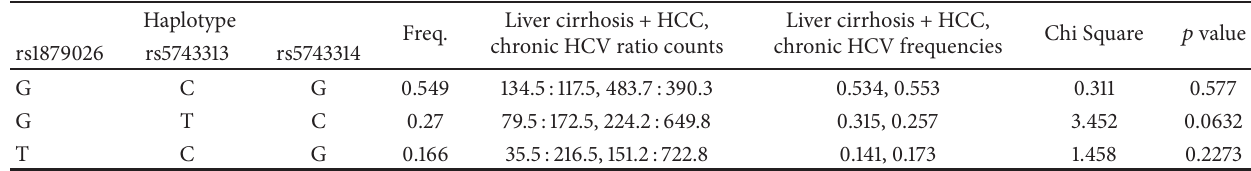
Table 7: Haplotype frequenciesof TLR3 SNPs in chronicHCV-infectedpatients compared to patientswith cirrhosis + HCCinfected patients.